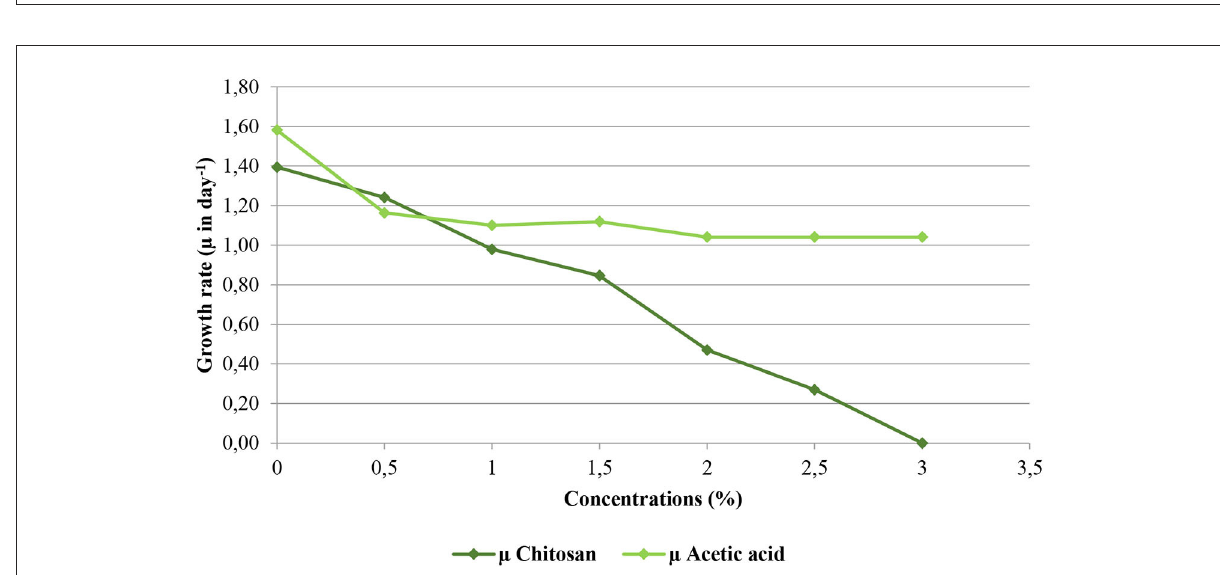
FIGURE4 Growth rate ( µ ) of Aspergillus niger according to the concentrations of chitosan and acetic acid.